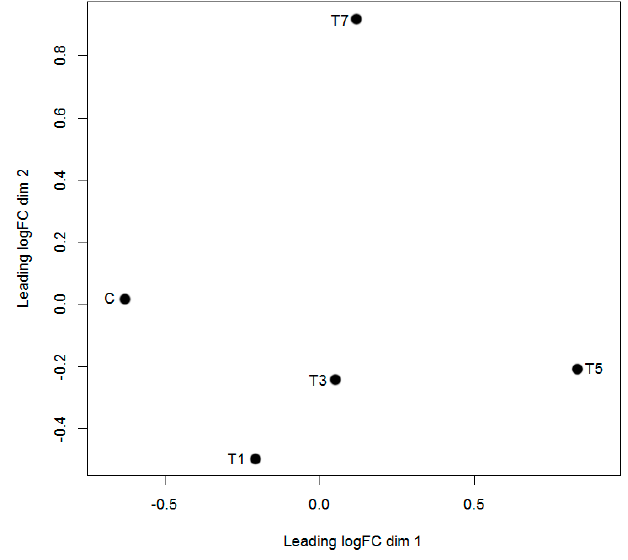
Figure 2. Biological coefficient of variation (BCV) of the five samples. In the plot, dim 1 shows differences between control and infected samples, whereas dim 2 shows differences among infected samples. X axis indicated the coefficient of variation between control sample and infected samples, whereas Y axis represented the coefficient of variation within the infected samples.